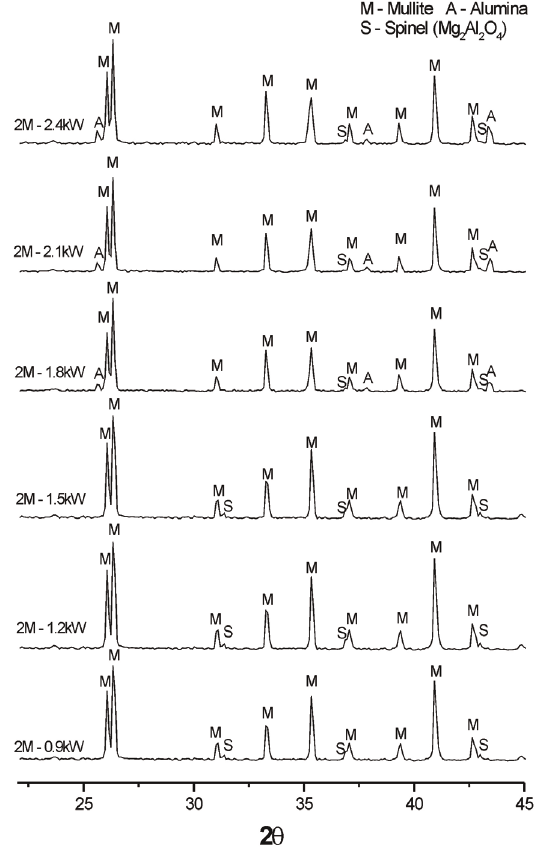
Figure 4. XRD patterns of the conventionally and fast sintered 2M samples.